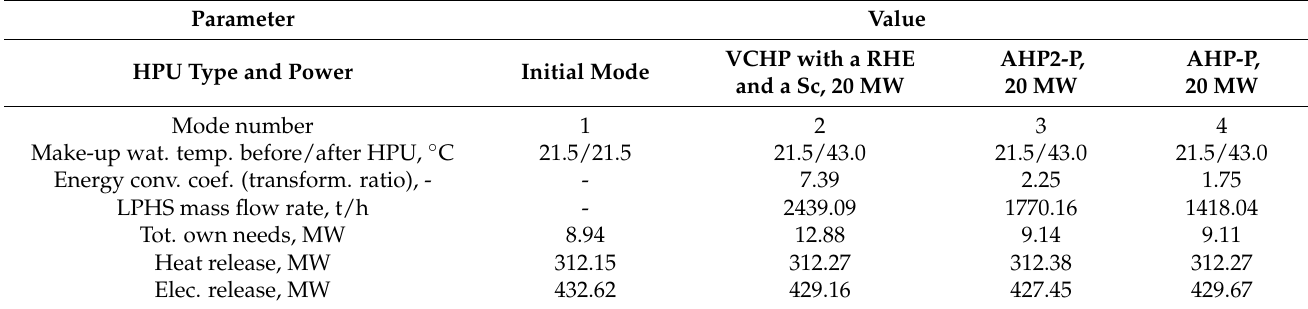
Table 7. Winter modes simulation results of using HPUs for heating make-up water with a flow rate of 800 t/h.